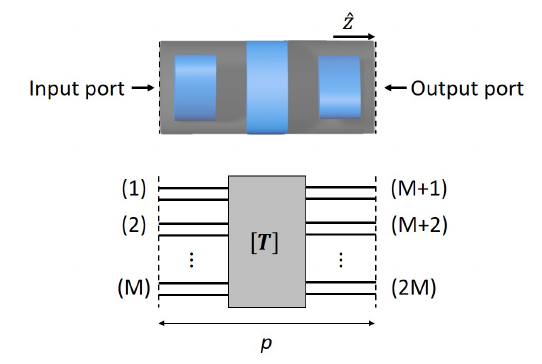
Figure 7. Top view of the unit cell and the transfer matrix of its equivalent